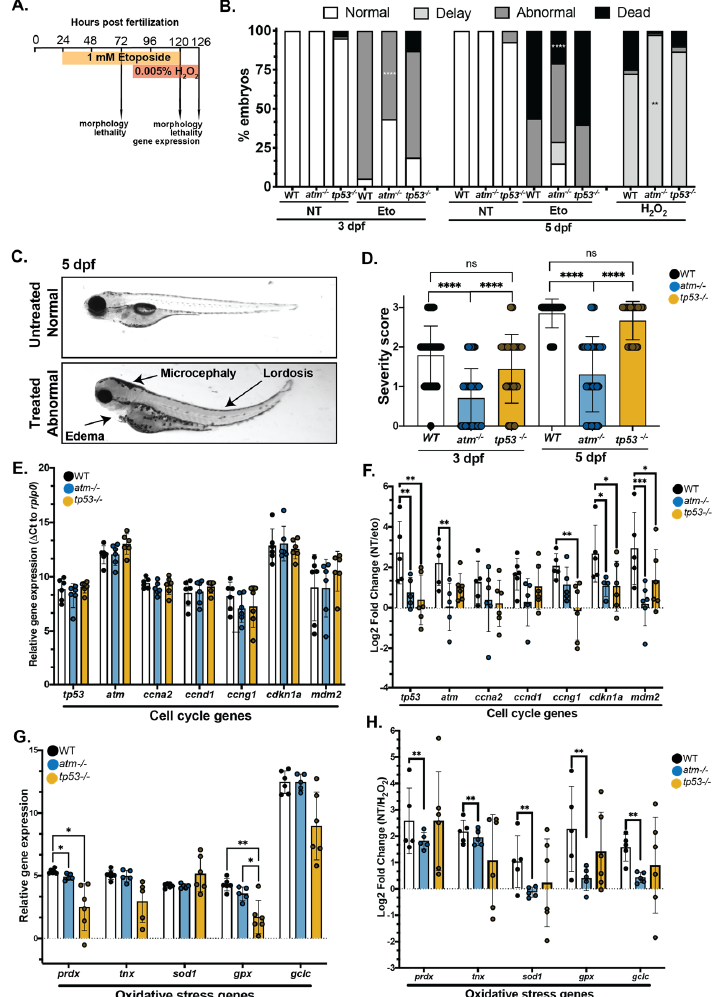
Figure 4. atm mutation suppresses the toxic response to etoposide or H 2 O 2 exposure ( A ) Treatment scheme for exposure to etoposide and H 2 O 2 . ( B ) The percent of WT, atm − / − and tp53 − / − embryos that have morphological defects or lethality in response to etoposide or H 2 O 2 . The experiments were performed on 6–8 clutches for each genotype and with 10 larvae per clutch (total 60 larvae). ( C ) Representative images of etoposide treated and untreated larvae at 5 dpf illustrating different phenotypes induced by etoposide treatment. Arrows indicate the phenotypes used to assign a severity score. ( D ) The phenotype severity score of etoposide treated larvae at 3 and 5 dpf in WT, atm − / − and tp53 − / − larvae. The severity score for all untreated larvae for all genotypes was zero. The experiment was performed on 6 independent biological replicates for each genotype. Each dot represents 1 larva. ( E ) qPCR analysis of tp53 target genes normalized to rplp0 expression in untreated 3 dpf larvae. There are no significant differences between samples. ( F ) The log2 fold change of WT, atm − / − and tp53 − / − 3 dpf embryos treated with etoposide compared to untreated embryos of the same genotype. The experiment was performed on 4–6 independent biological replicates for each genotype, with each dot representing values in a